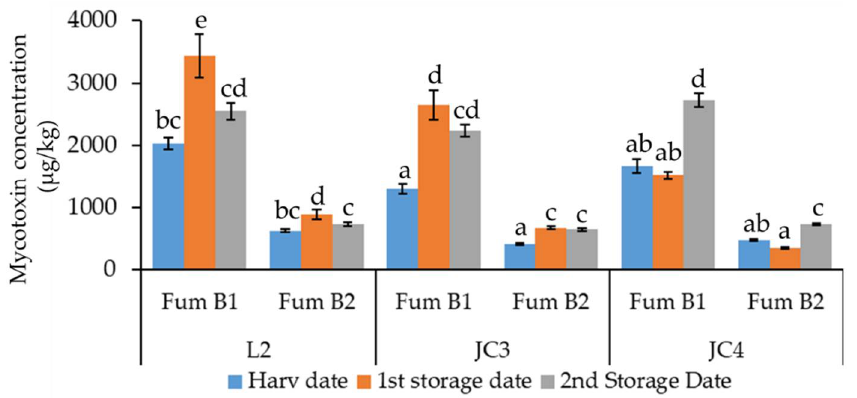
Figure 4. Accumulation of fumonisins in maize grain (L2, JC3, and JC4) at harvest (Harv date), four months of storage (1st storage date), and six months of storage (2nd storage date) in barrels. The absence of common letters indicates significant differences at p < 0.05, the Tukey’s multiple range tests were performed for each fumonisin.